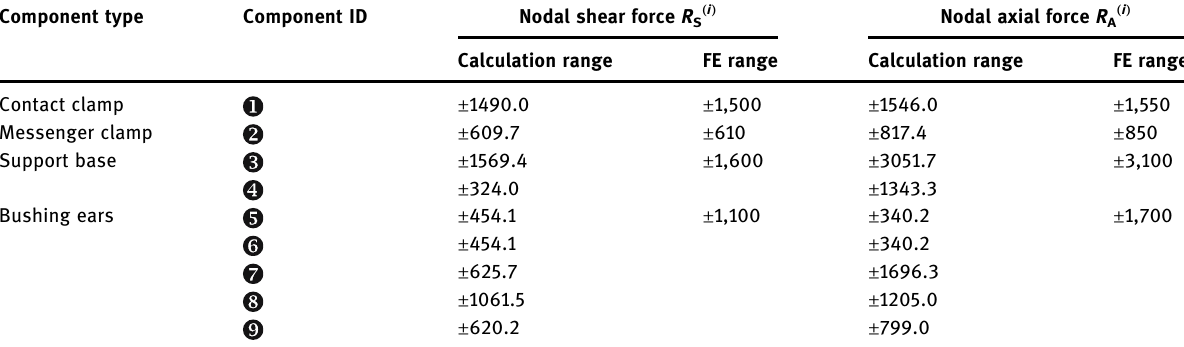
Table 6: Nodal force range and FE load magnitude definition ( Unit: N